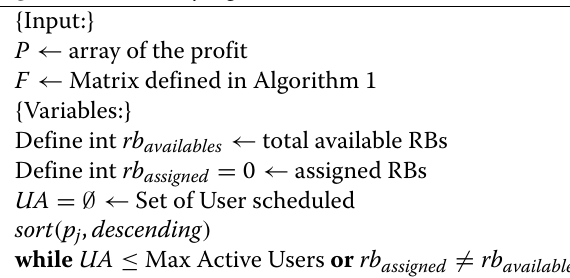
Algorithm 2 Greedy